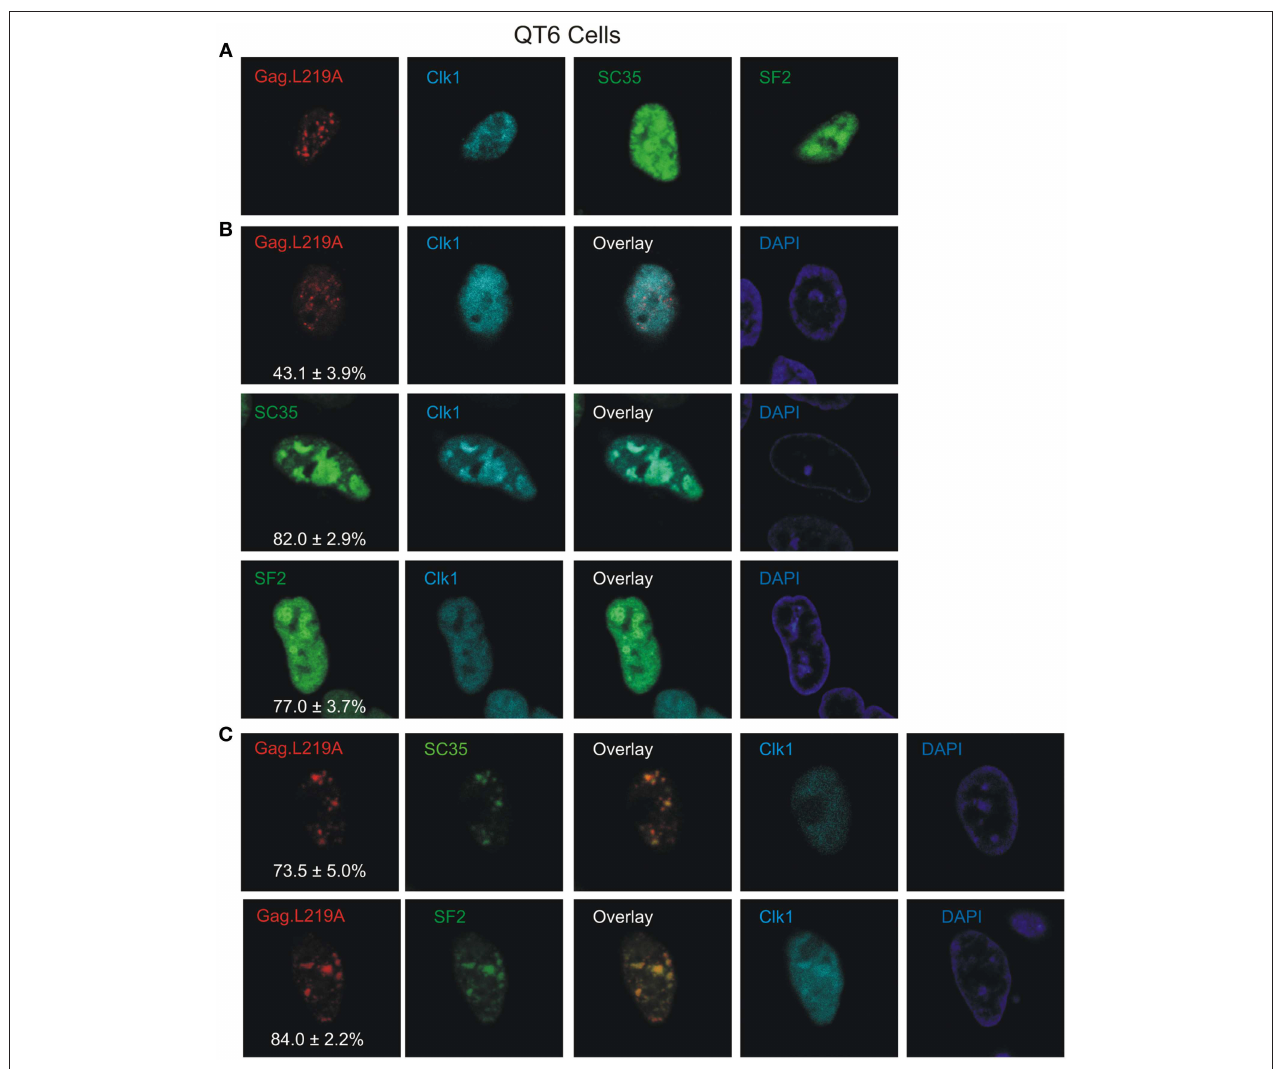
FIGURE 5 | The effect of Clk1 on Gag.L219A localization in QT6 cells. (A) Localization of Gag.L219A, Clk1, SC35, or SF2 in singly transfected QT6 cells. (B) Co-expression of Clk1 with Gag.L219A, SC35, or SF2 in QT6 cells. “Overlay” depicts a merge of the Clk1 and Gag.L219A or splicing factor channels. The DAPI channel is also displayed. The percentage of Gag.L219A, SC35, or SF2 co-localizing with Clk1 is depicted in the corresponding Gag.L219A, SC35, and SF2 channels with the standard error of the mean. (C) QT6 cells co-transfected with Gag.L219A, Clk1, and SC35 (top panel) or SF2 (bottom panel). Merging the Gag.L219A and splicing factor channels results in the “Overlay” channel. The DAPI channel is also displayed. The percentage of Gag.L219A co-localization with SC35 or SF2 in the presence of Clk1 overexpression is depicted in the corresponding Gag.L219A channel with the standard error of the